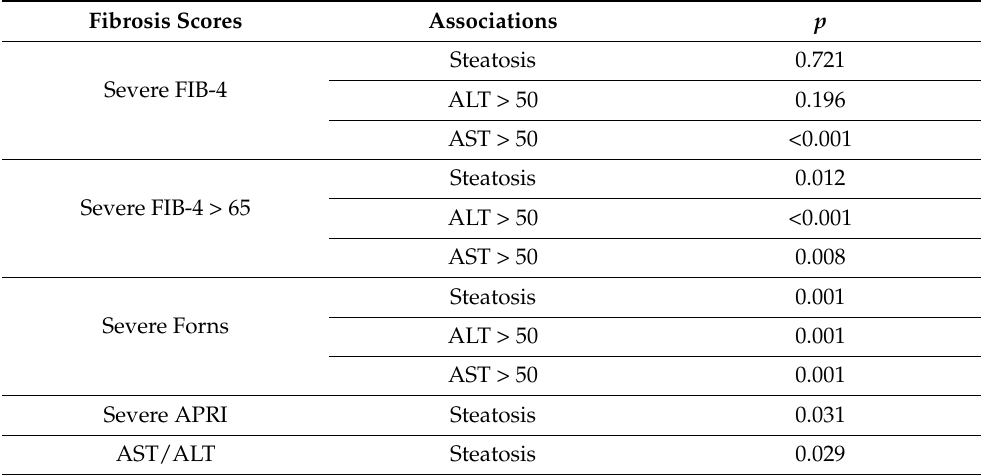
Table 4. Association between fibrosis severity, steatosis, and markers of liver injury.